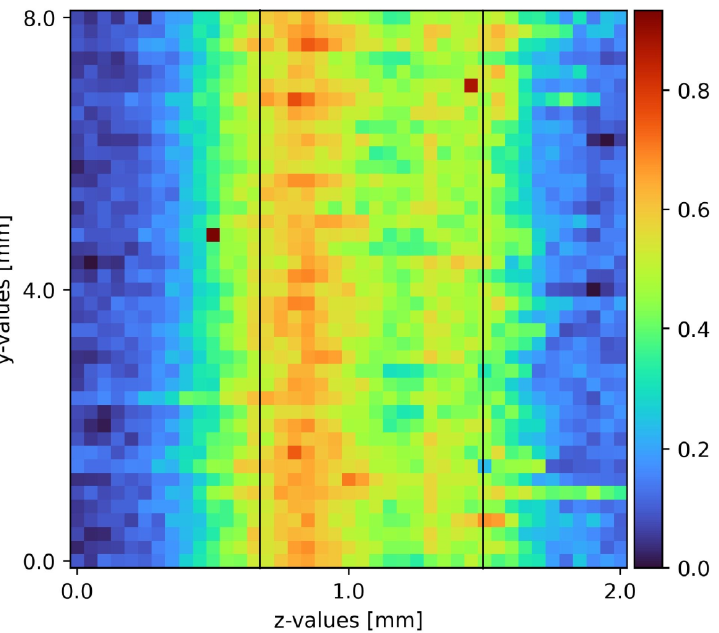
Figure 4. Sodium sulfate film on a plain surface falling film spatial before the disturbance. The black bars indicate the boundaries of the sodium sulfate film with air left on the left and the surface at the right.